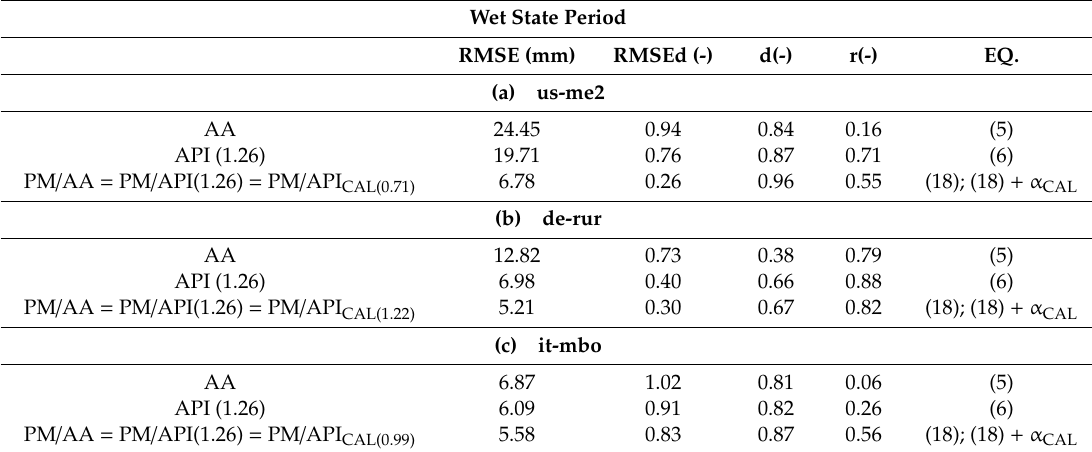
Table 4. Goodness-of-fit indices for the four applied models. Errors are computed on monthly AET time series for the wet state period (AA = the advection-aridity method; API (1.26) = the API corrected potential evapotranspiration with α = 1.26; PM / AA = the Penman / advection-aridity threshold model; PM / API(1.26) = the Penman / API corrected potential evapotranspiration threshold model with α =